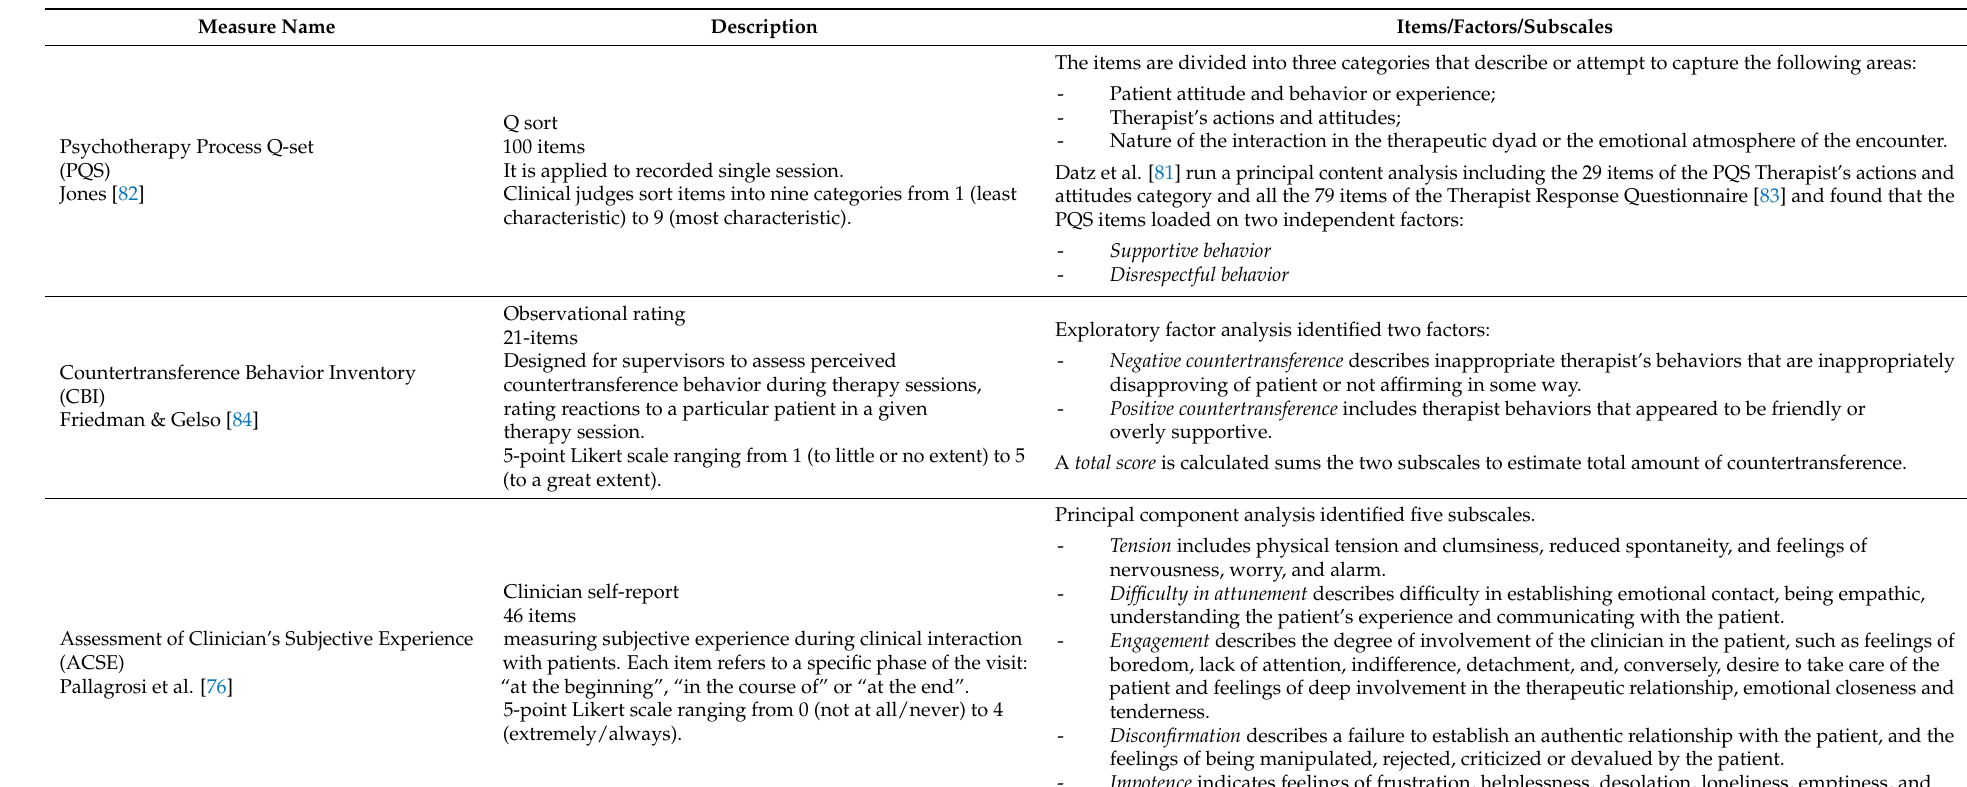
Table 1. Measures used for the assessment of clinicians’ reactions toward the